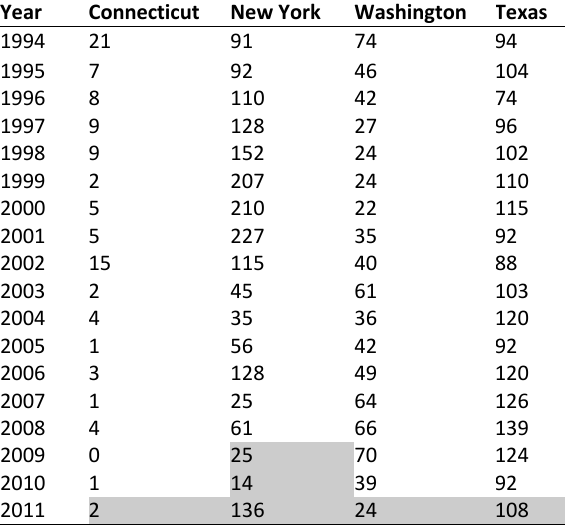
Table 2. Juvenile prostitution arrests by State: